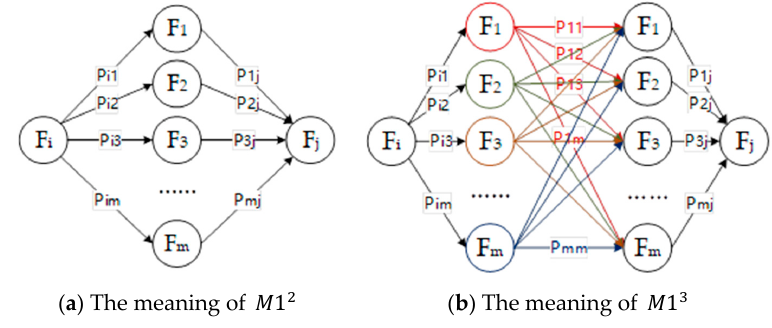
Figure 2. The meanings of M 1 2 and M 1 3 .